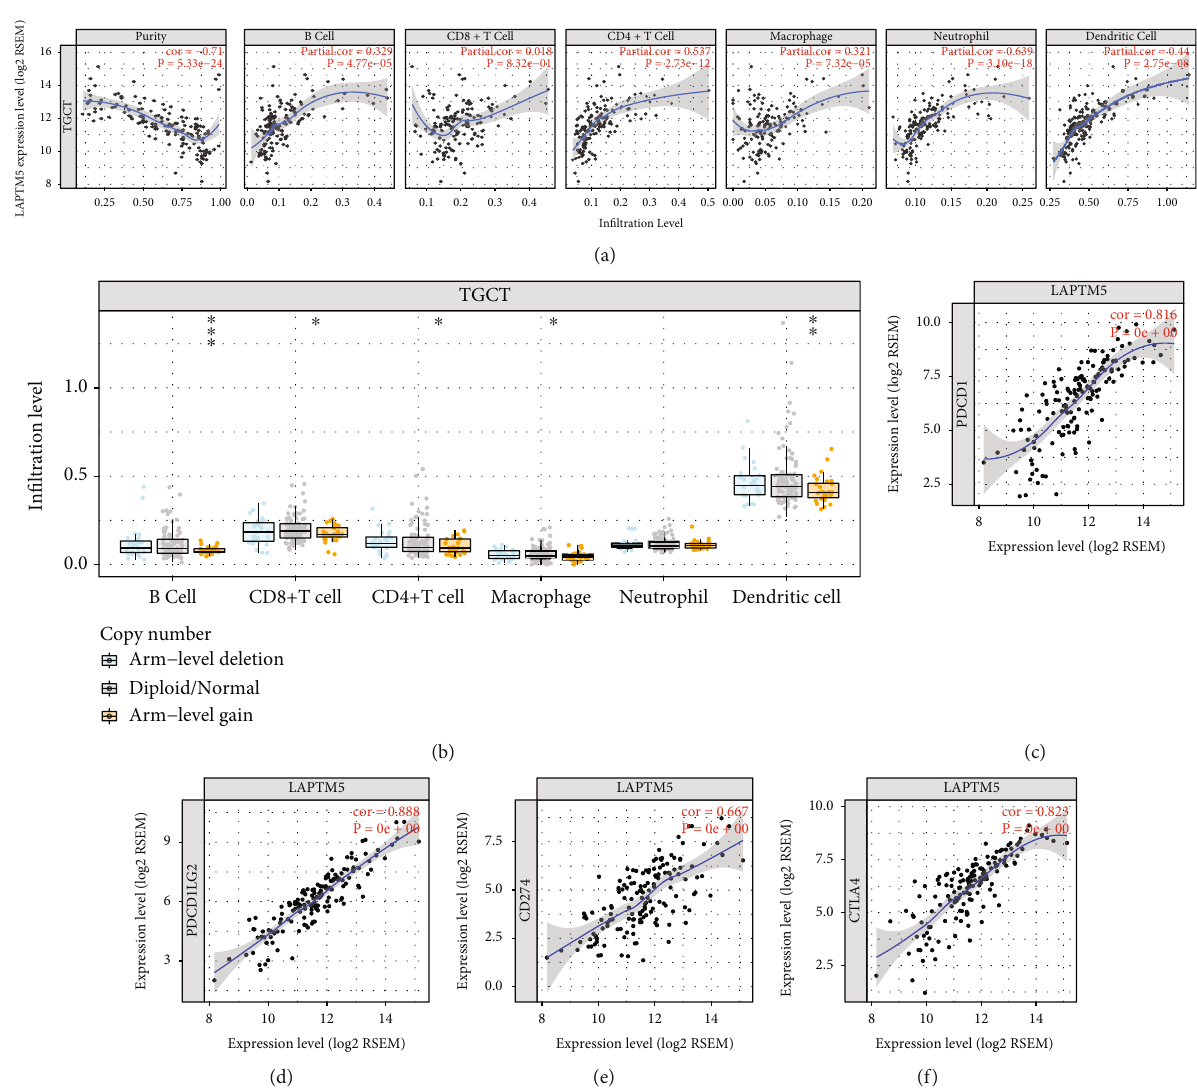
Figure 8: Relationship between LAPTM5 and immune responses. (a, b) Relationship between LAPTM5 and immune in fi ltration. ∗ P < 0 : 05 , ∗∗ P < 0 : 01 , ∗∗∗ P < 0 : 001 . (c – f) Relationship between LAPTM5 and immune checkpoints. P values are